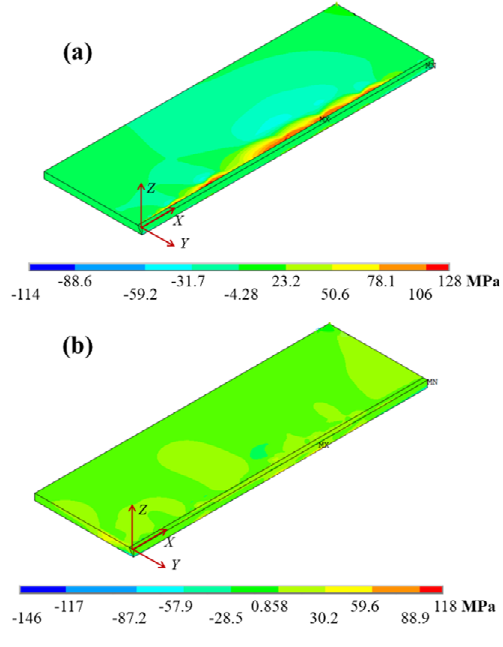
Figure 14. Residual stresses generated on the welded plates without restriction: ( a ) X-direction and ( b ) Y-direction.